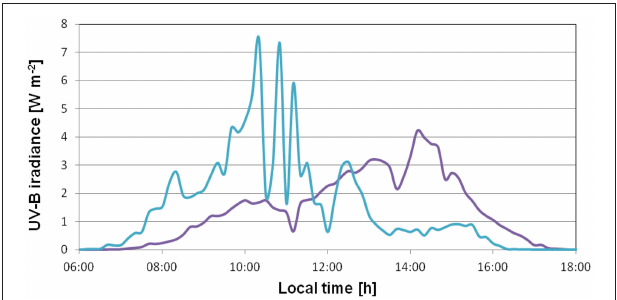
FIGURE 1 | UV-B irradiances measured on 16 January 2004 on Licancabur (22.48 ◦ S/67.47 ◦ W, 5917m a.s.l.; blue) and at Laguna Blanca (22.50 ◦ S/67.53 ◦ W, 4340m a.s.l.;